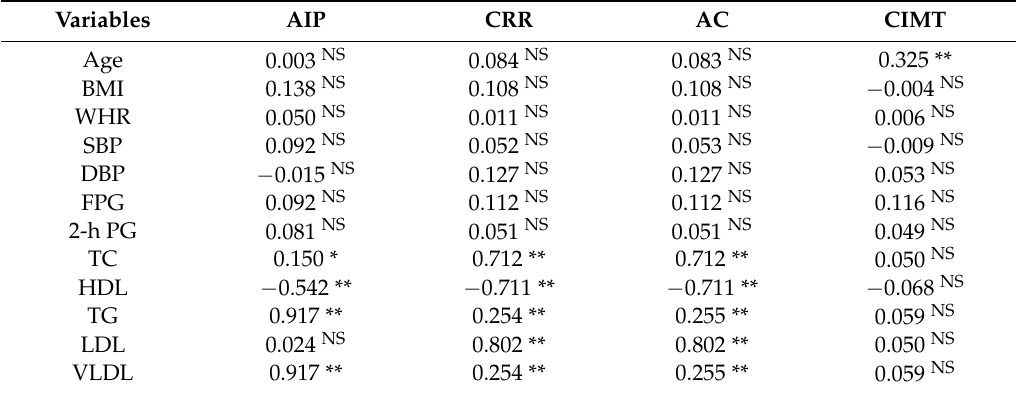
Shows correlation of AIP, CRR, AC, and CIMT with cardiovascular risk factors in control